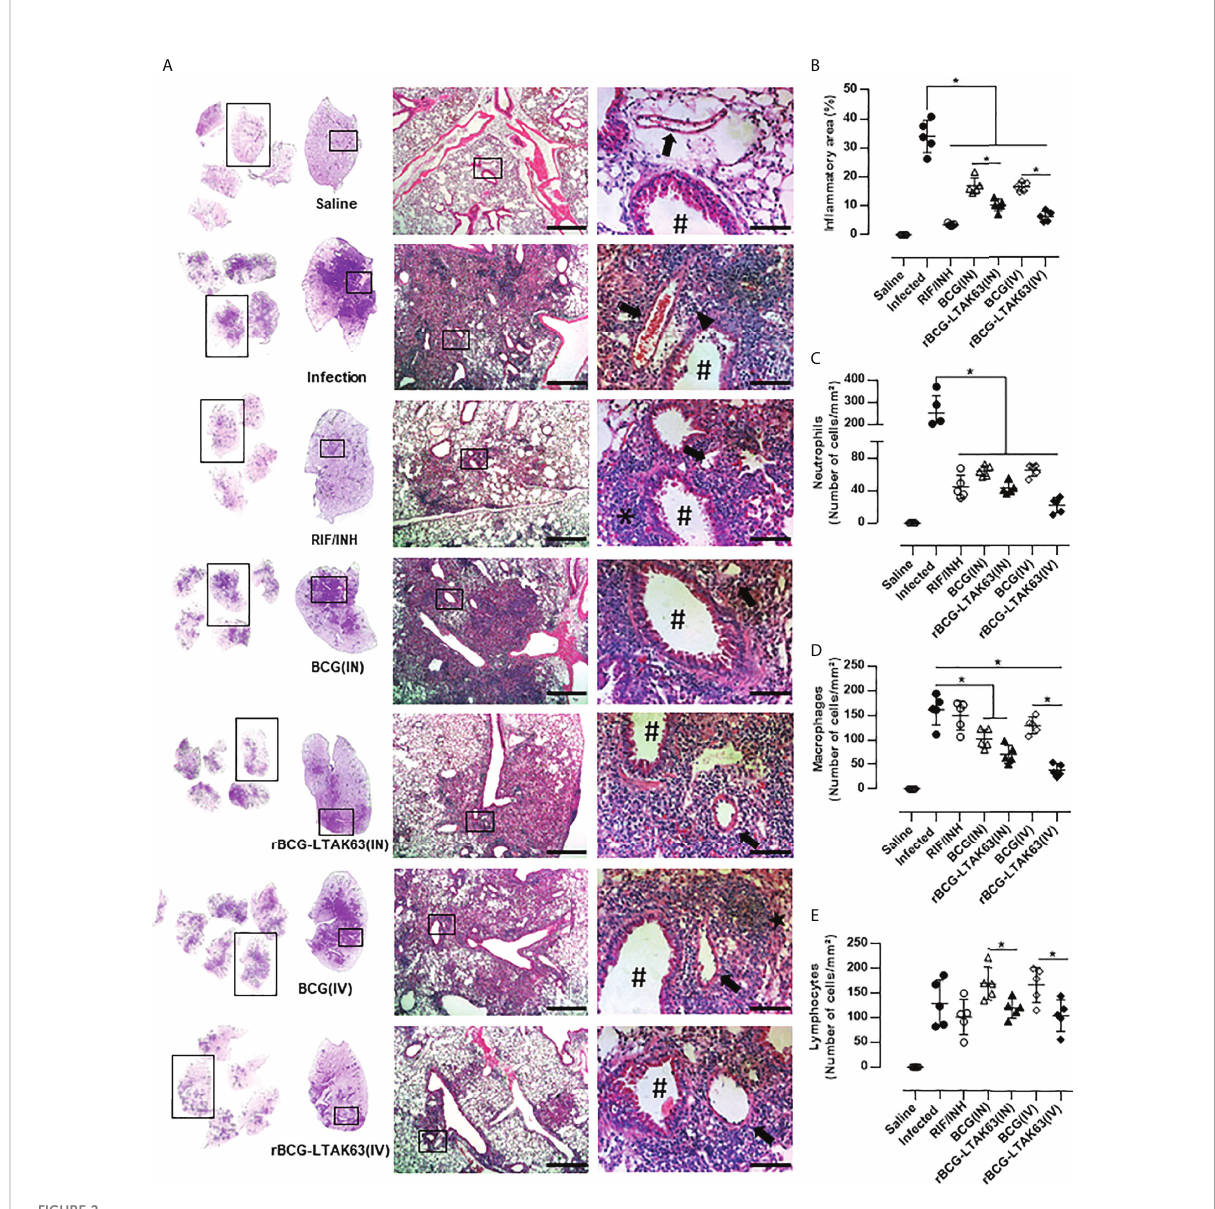
FIGURE 2 Immunotherapy with rBCG-LTAK63 vaccine decreases cellular in fi ltration in the lungs of Mtb -infected mice. (A) Representative histopathology of lungs from naïve mice (Saline), infected with Mtb and not treated (Infection), treated with antibiotics for 4 weeks (RIF/INH) or treated with BCG or rBCG-LTAK63 delivered intranasally (IN) or intravenously (IV), at 1x, 5x and 20x magni fi cation. Representative images at 40x magni fi cation show the difference in in fl ammatory process between treatments, neutrophilic in fi ltrate (arrowhead), interalveolar macrophage (star) and lymphocyte (asterisk), arteriole (arrow) and bronchioles (hashtag). (B) Lung in fl ammation scores are presented as the mean percentage of in fl ammation area (mm²) for each mouse (n=5/group). The cellular in fi ltrate in the lung sections was classi fi ed in neutrophils (C) , macrophages (D) and lymphocytes (E) and presented as cell counts per mm². Lung sections were stained with H&E (bar, 200 μm (5x) and/20 μm (20x). Statistical differences were determined by one-way ANOVA with a Bonferroni test. *p <